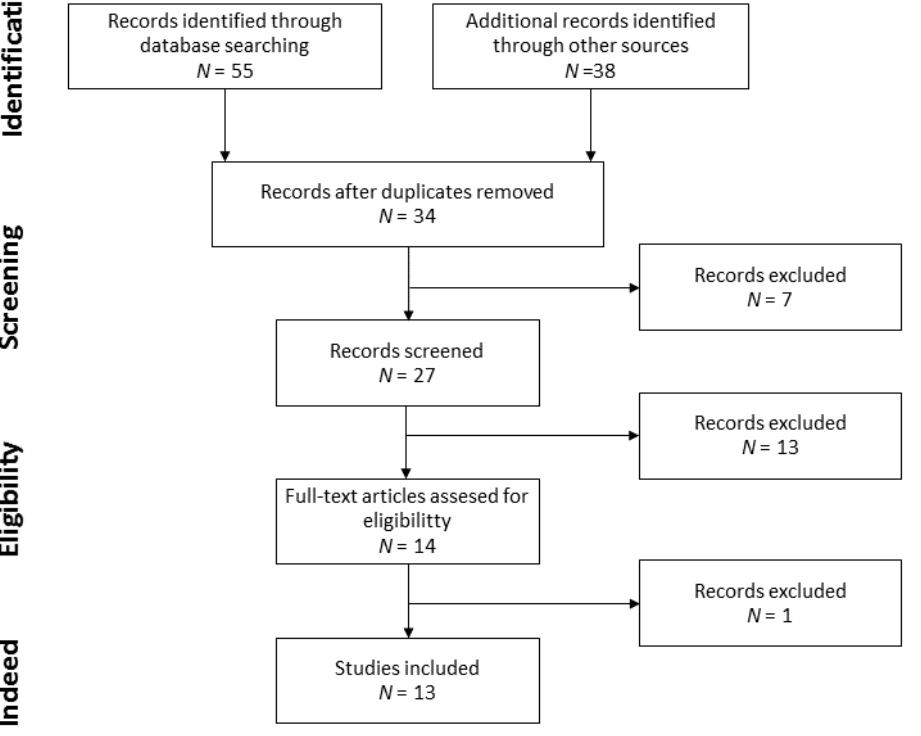
Figure 1. Flow diagram of record selection.